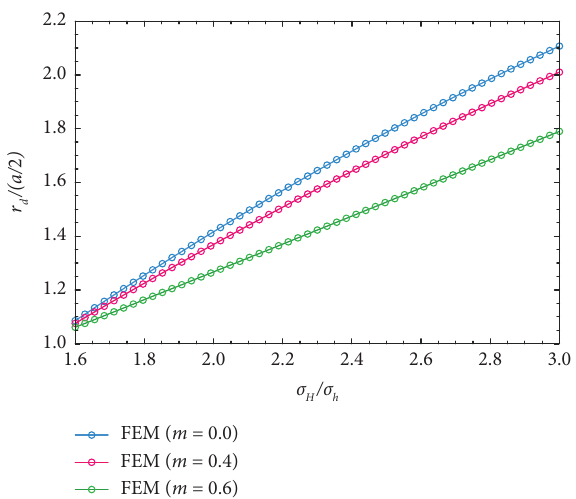
Figure 14: Final normalized breakout depth versus in situ stress ratio for diferent eccentricities.